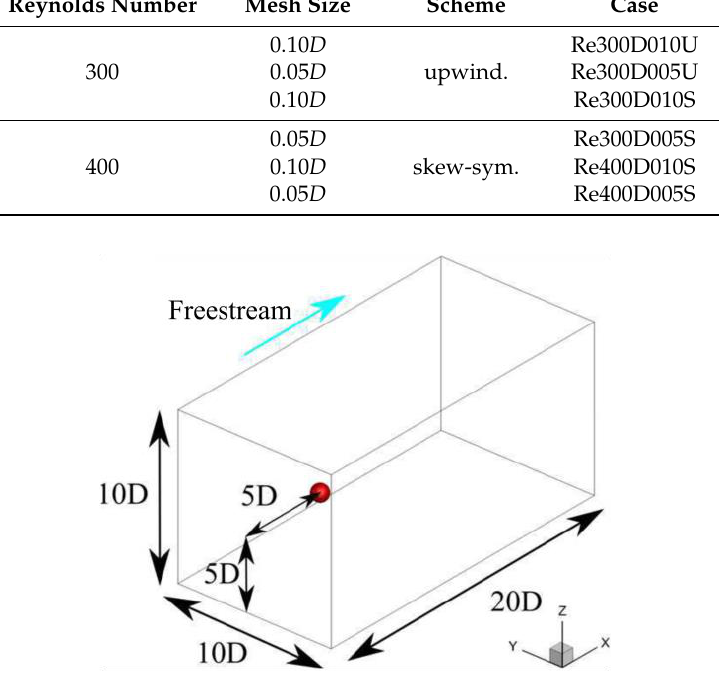
Figure 3. Computational domain. The red sphere is the object. Figure 4 plots the mean drag coefficient versus Reynolds